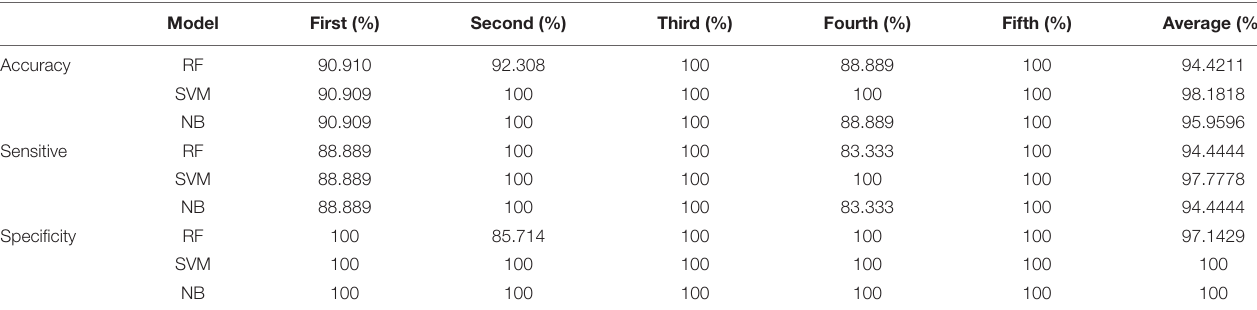
FIGURE 4 | ROC curve analysis for the four classifiers. (A) CF. (B) RF-based, SVM-based and NB-based classifiers. ROC, receiver operating characteristic; CF, cancer factor; RF, random forest; SVM, support vector machine; NB, naive Bayes. TABLE 4 | Results of fivefold cross-validation of three classifiers with machine